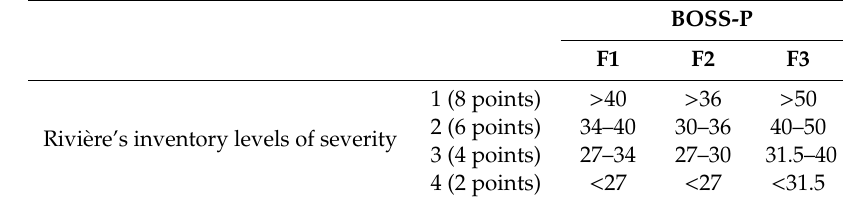
Table 5. Combination of the level of a ff ectation in the Rivi è re’s Inventory and the Behavioral Observation on Sensory Stimuli Questionnaire for Parents’ (BOSS-P) interquartile